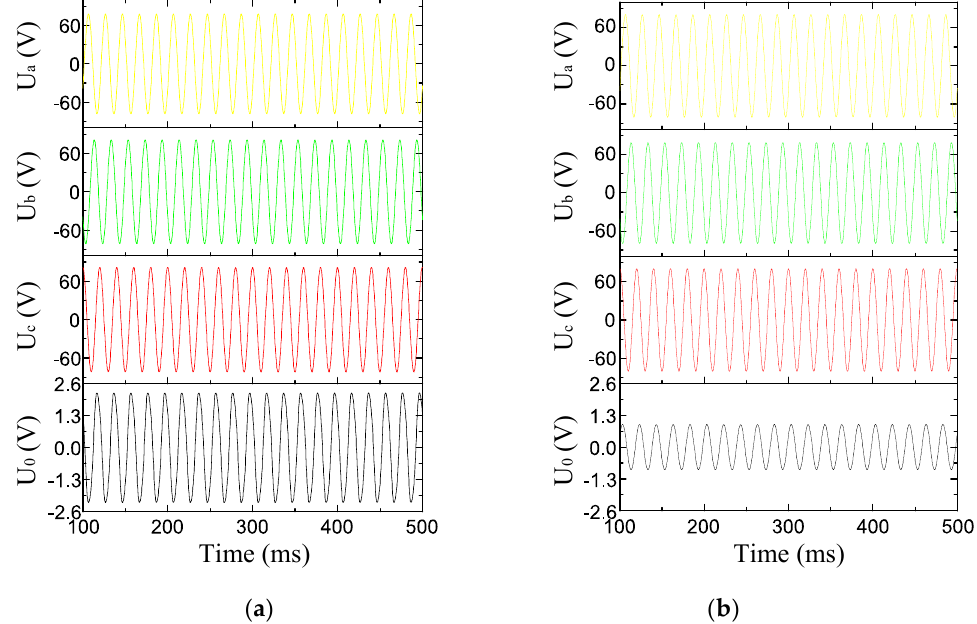
Figure 6. Simulation results for the VT secondary voltage waveform. ( a ) Normal insulation; ( b ) insulation breakdown.